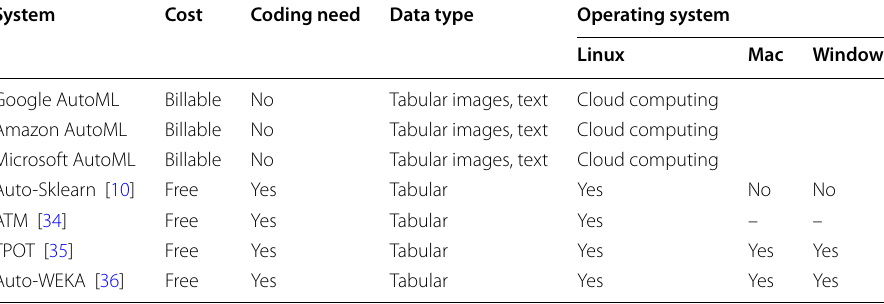
Table 1 Summary of related AutoML systems